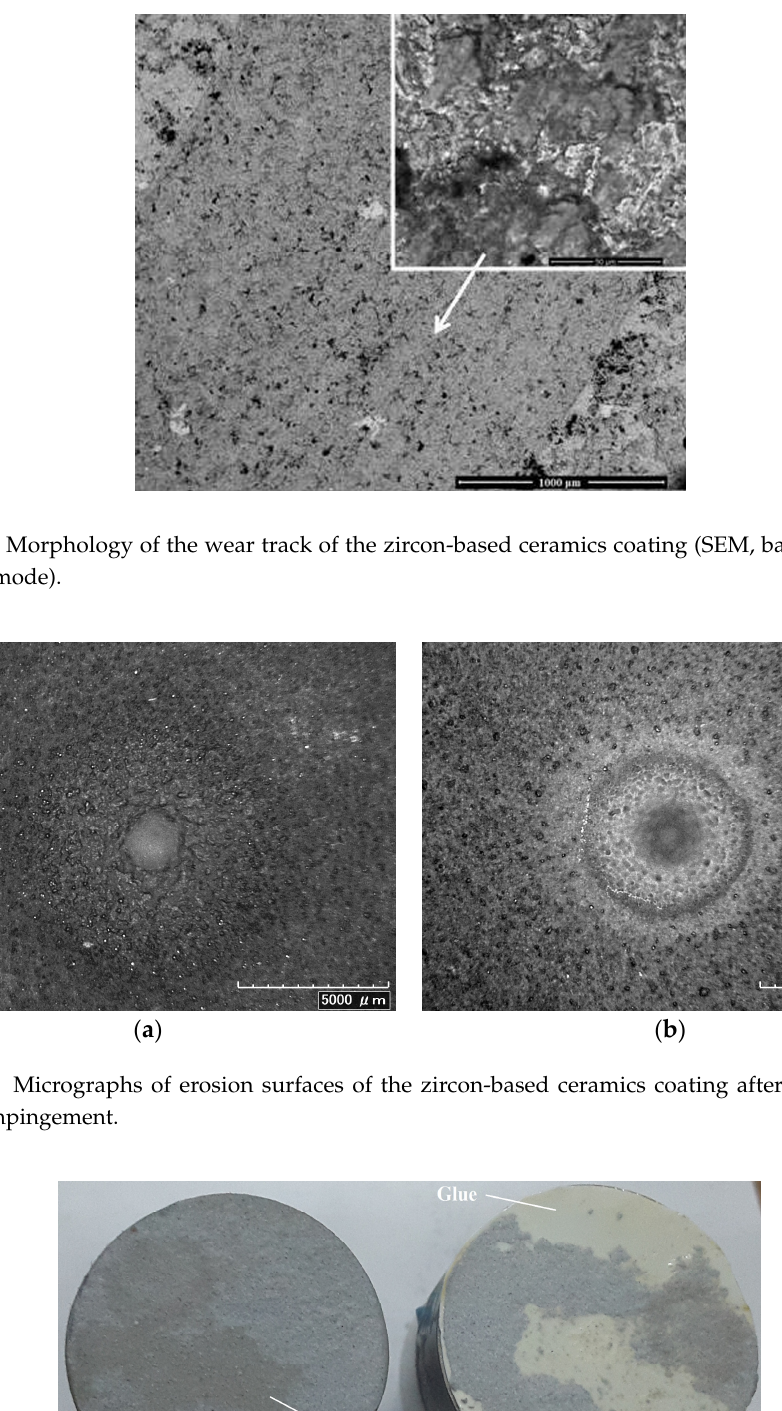
Figure 6. Microcracking propagation from the Vickers indentation in the zircon ‐ based ceramics coating (SEM, back ‐ scattered electron mode).